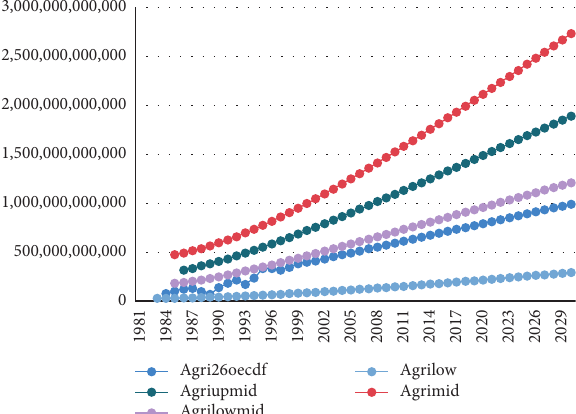
by the BJ method. Source: drawn by the